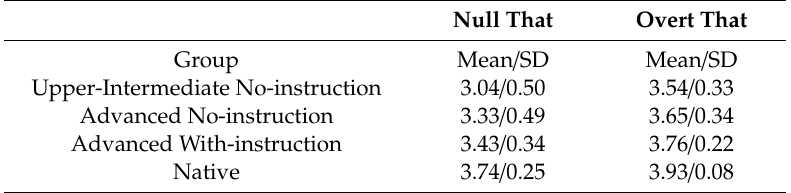
Table 1. Descriptive statistics of acceptability judgments in each condition (by